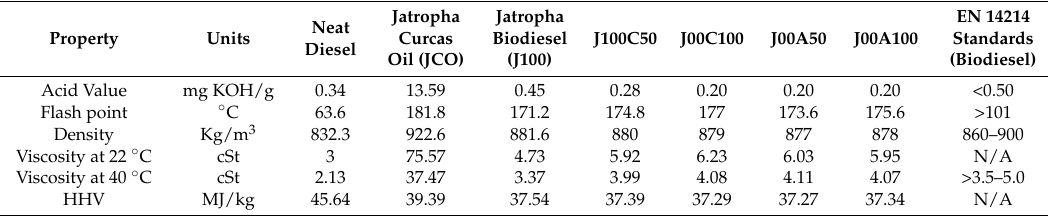
Table 2. Measured properties of the test fuels.